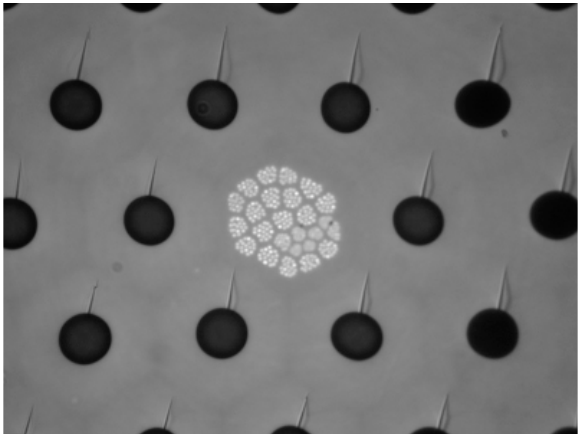
Figure 8. Optical micrograph of the core region of a fiber preform, showing 425 small doped regions within the core. Pitch 90 μm . [Reprinted/Adapted] with permission from [78] © The Optical Society .